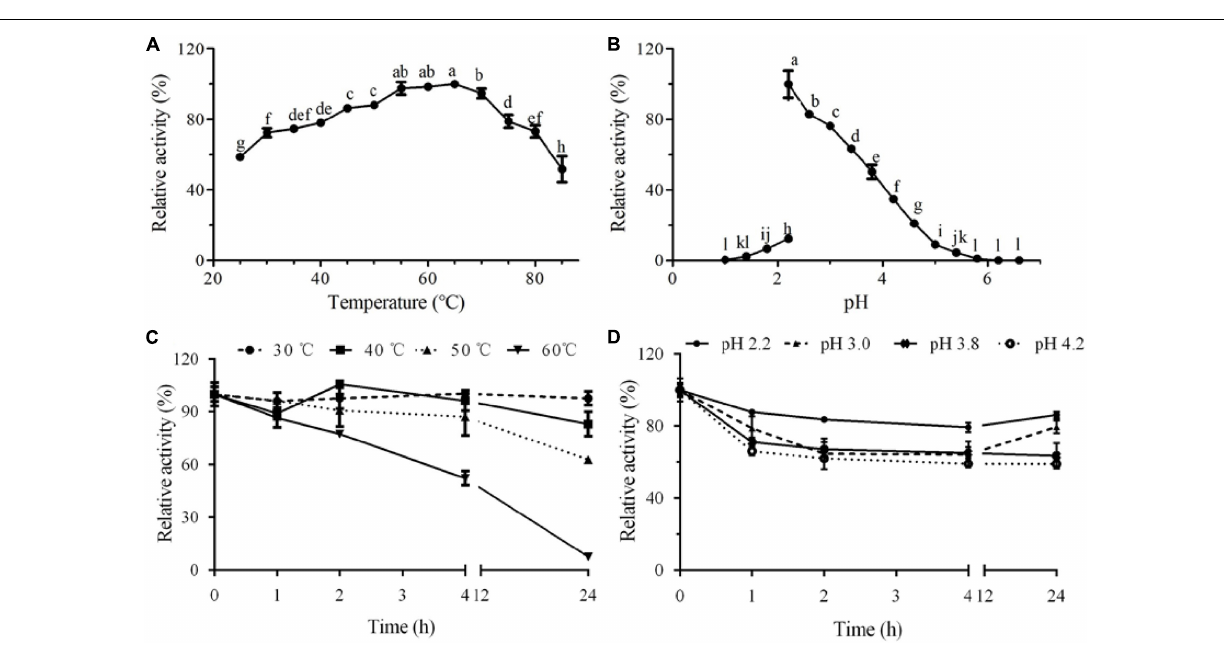
FIGURE 3 | Effect of temperature and pH on activity and stability of the purified laccase GLL. (A) optimal temperature; (B) optimal pH; (C) thermal stability; and (D) pH stability. The letters denoted the statistical significance according to the Tukey test at P <